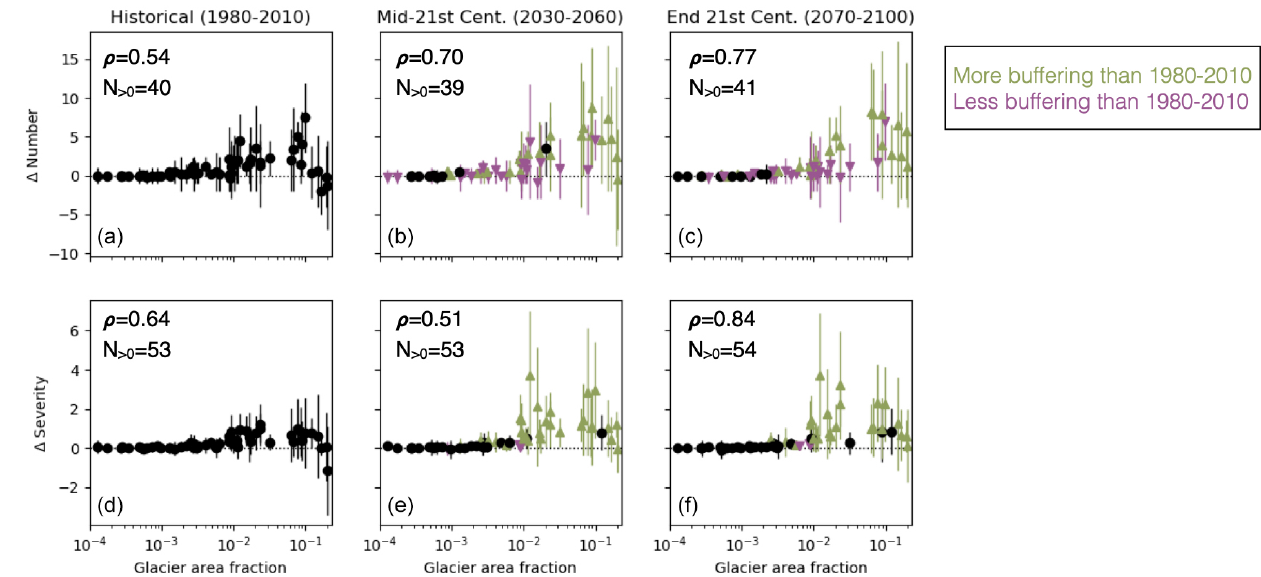
Figure 3. Glacial buffering of the number of droughts (a–c) and drought severity (d–f) , for the periods 1980–2010 (a, d) , 2030–2060 (b, e) , and 2070–2100 (c, f) . Differences are given as the statistic on SPEI N − SPEI G , so a positive y -axis means positive buffering, i.e., there are more, and/or more severe, droughts in the without-glacial runoff series. X -axes are glacier area fraction A g /A presented on a logarithmic scale. Markers indicate the ensemble mean for each basin and whiskers indicate range among single-GCM results. In the second and third columns, color indicates change in ensemble mean buffering versus the historical period: green upward triangles for increased buffering, black dots for no change (tolerance of ± 0.1), and magenta downward triangles for decreased buffering. Annotations in the corner of each panel list Spearman’s rank correlation coefficient ρ between the basin glaciated area and the statistic shown in that panel, as well as the number of basins for which multi-model mean buffering is positive, N > 0 . Results shown here pertain to the RCP 4.5 scenario; see results for RCP 8.5 in Fig. A2. Table 1. Spearman’s rank correlation ρ between RCP 4.5 drought statistics shown in Fig. 3 (rows) and basin-level variables (columns). Boldface indicates p < 0 . 01. The variables tested here are described in Sect. 2.4; the abbreviation “AI” indicates the aridity index. Statistic % Glaciated Basin Historical Historical area